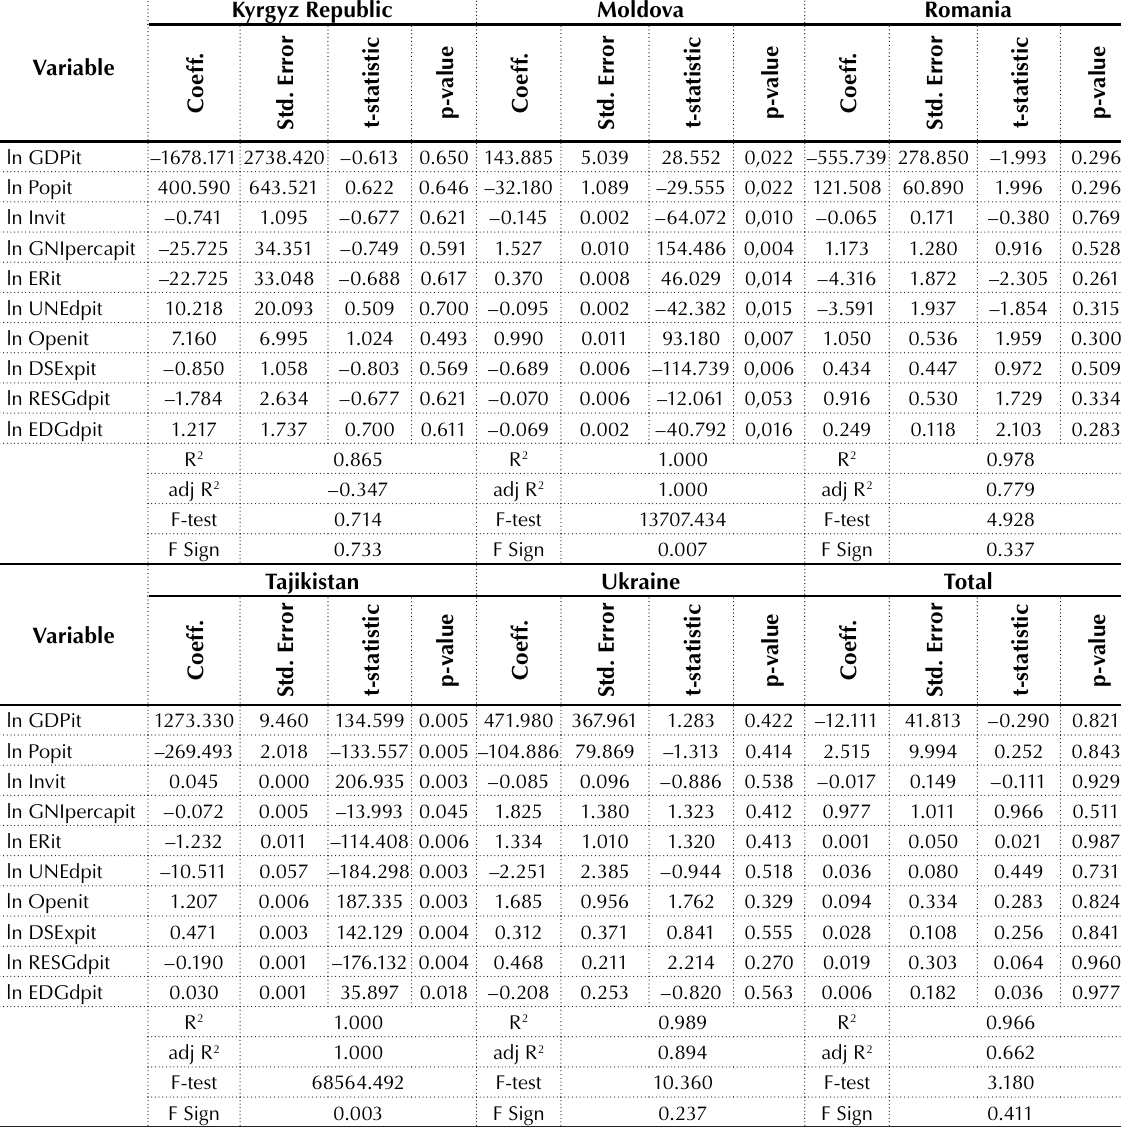
Table A. (cont). Fixed effects panel regression for each variable in each country, 2006−2016